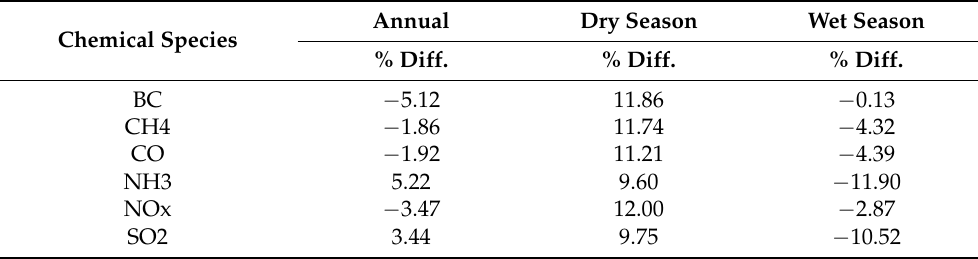
Table 2. The percentage difference in annual, dry season and wet season of total emission of BC, CH 4 , CO, NH 3 , NO x , and SO 2 between the time periods of 1990–1999 and